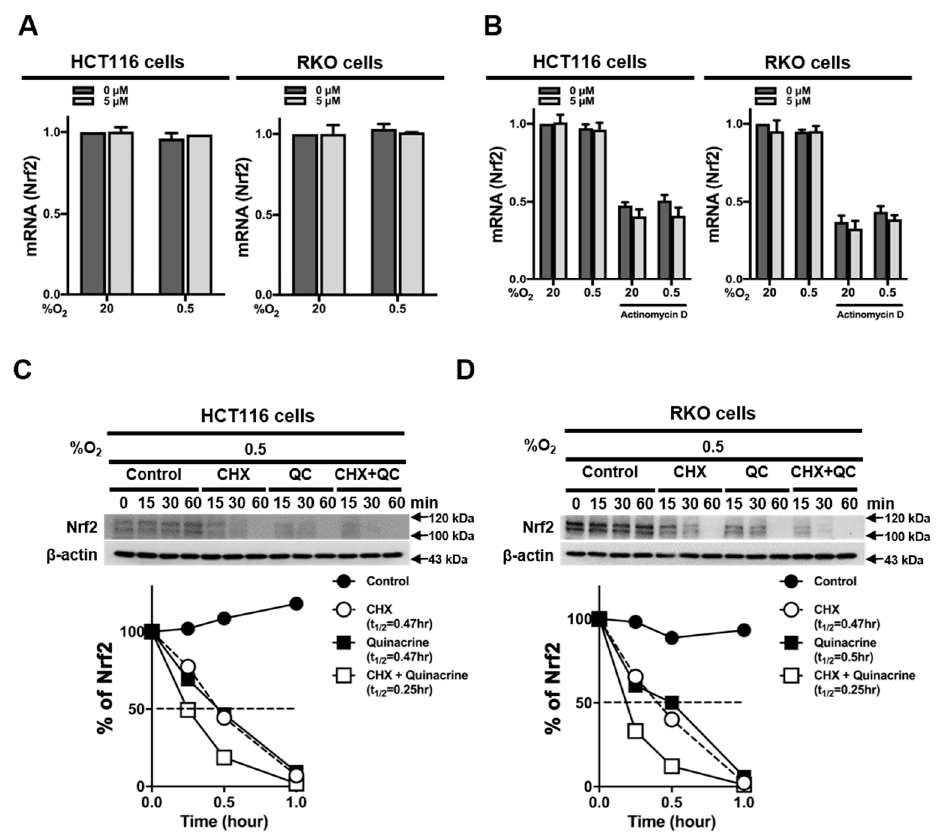
Figure 3. QC decreases Nrf2 protein stability in CRC cells. ( A,B ) E ff ects of QC on Nrf2 mRNA expression ( A ) and Nrf2 mRNA stability ( B ) in HCT116 cells (left) and RKO cells (right). ( C,D ) E ff ect of QC on Nrf2 protein stability in HCT116 cells ( C ) and RKO cells ( D ) under hypoxic conditions. Nrf2 protein levels were quantified using Image J software; band intensities were normalized to those of β -actin (band intensity at t β -actin were 0 was defined as 100%). Representative images of Nrf2 and detected by immunoblot. Representative images of immunoblots for each protein were obtained using the same sample on di ff erent gels after a single